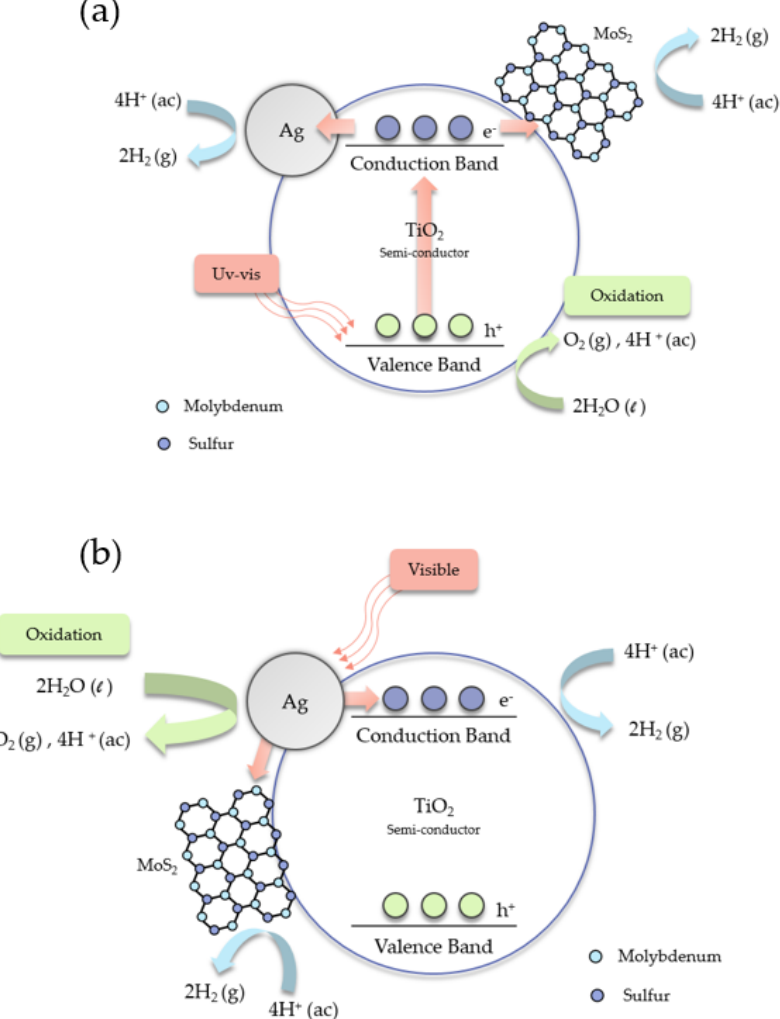
Figure 11. Mechanism proposed for the hydrogen production using Ag@TiO 2 -MoS 2 catalysts under ultraviolet ( a ) and visible light ( b ).